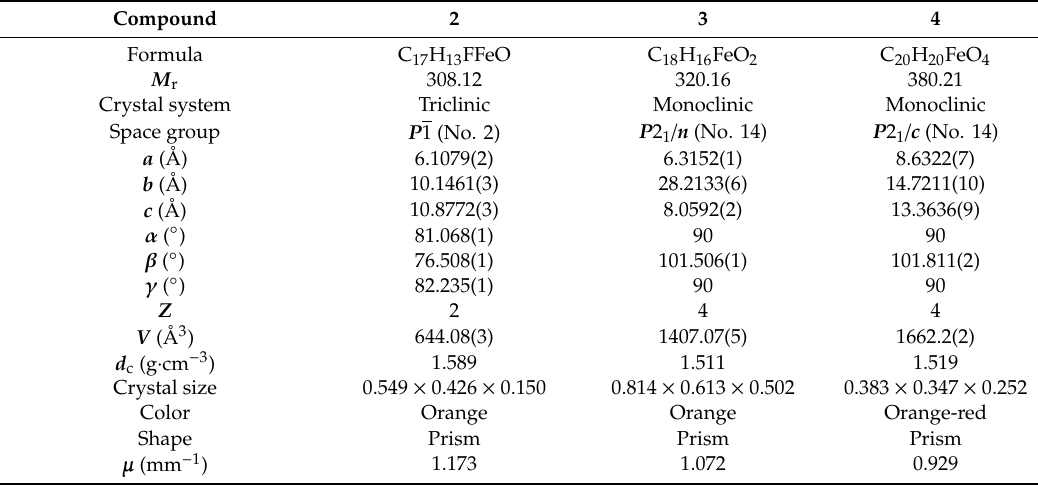
Table 1. Summary of crystallographic data for ferrocene